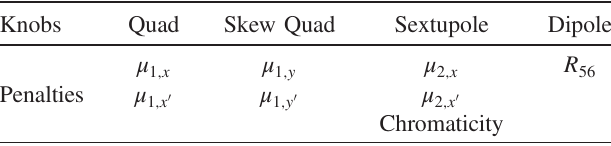
TABLE IV. Pairing for perturbation response matrix. Not mentioned elements are set to zero to increase